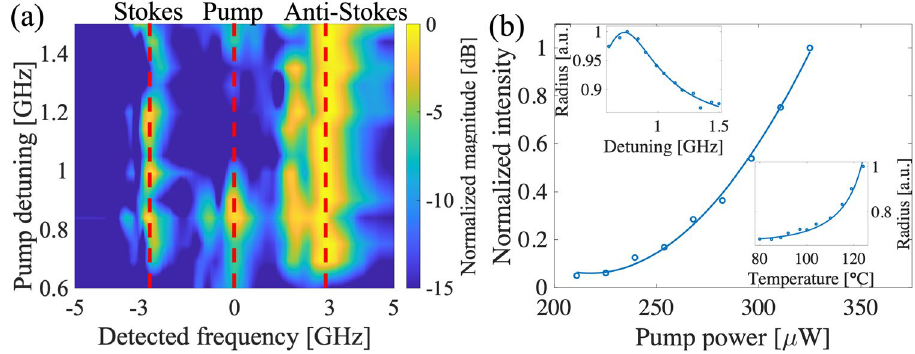
Figure 2. ( a ) Frequency spectrum of detected scattering signal for different pump detunings. The frequency is measured relative to the pump frequency. Red dashed lines indicate center frequencies of Stokes, pump, and anti-Stokes signals. ( b ) Scattering intensity within the ring region shows quadratic dependency with the pump power. Insets show the radius of the ring as a function of the pump detuning and the atomic cell temperature. The solid lines in the insets are theoretical fits using R 2 temperature-dependency of delay are δ t 85 Rb atoms 21 . A , B , C , and b are fitting